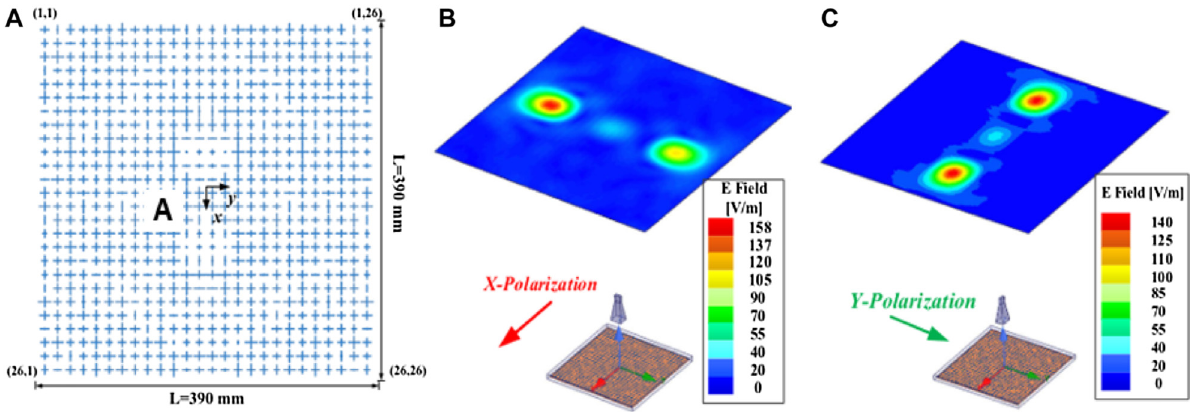
Figure 7: NFF metasurface for WPT. (A) The geometry of single-feed, dual-focus reflective metasurface. (B) and (C) Full-wave simulation of the multi-focus metasurface [74].